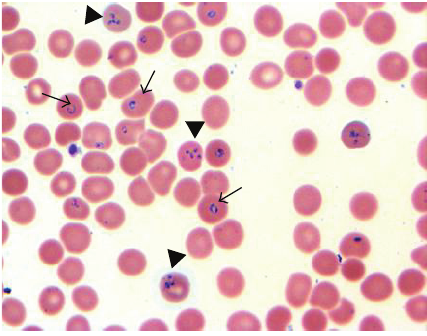
Figure 2: Red blood cells contain ring forms of B. microti (arrow) and tetrad (Maltese cross, arrow head),